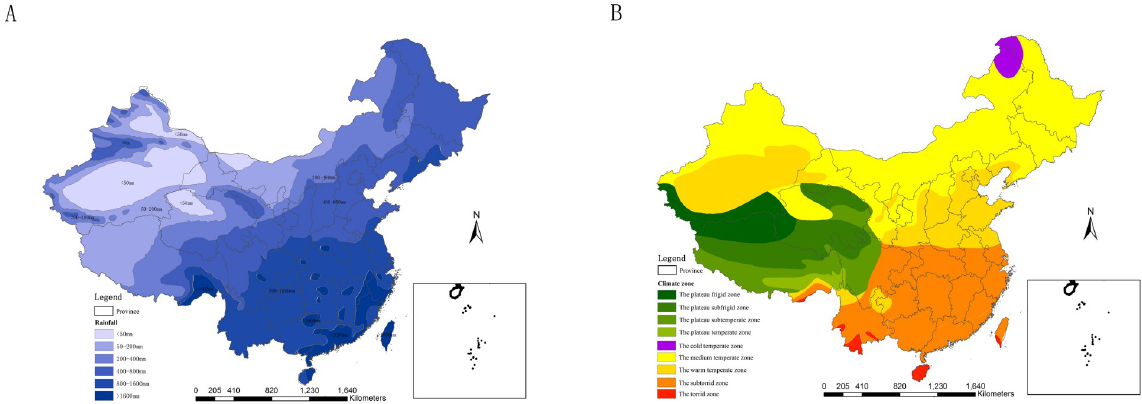
Fig 9. The yearly rainfall zone and the climate zone. A. the yearly rainfall zone. B. the climate zone. (Data of the yearly rainfall zone and the climate zone were obtained from Research Center for Eco-Environmental Sciences, Chinese Academy of Sciences. Figure 9 was created for this manuscript using